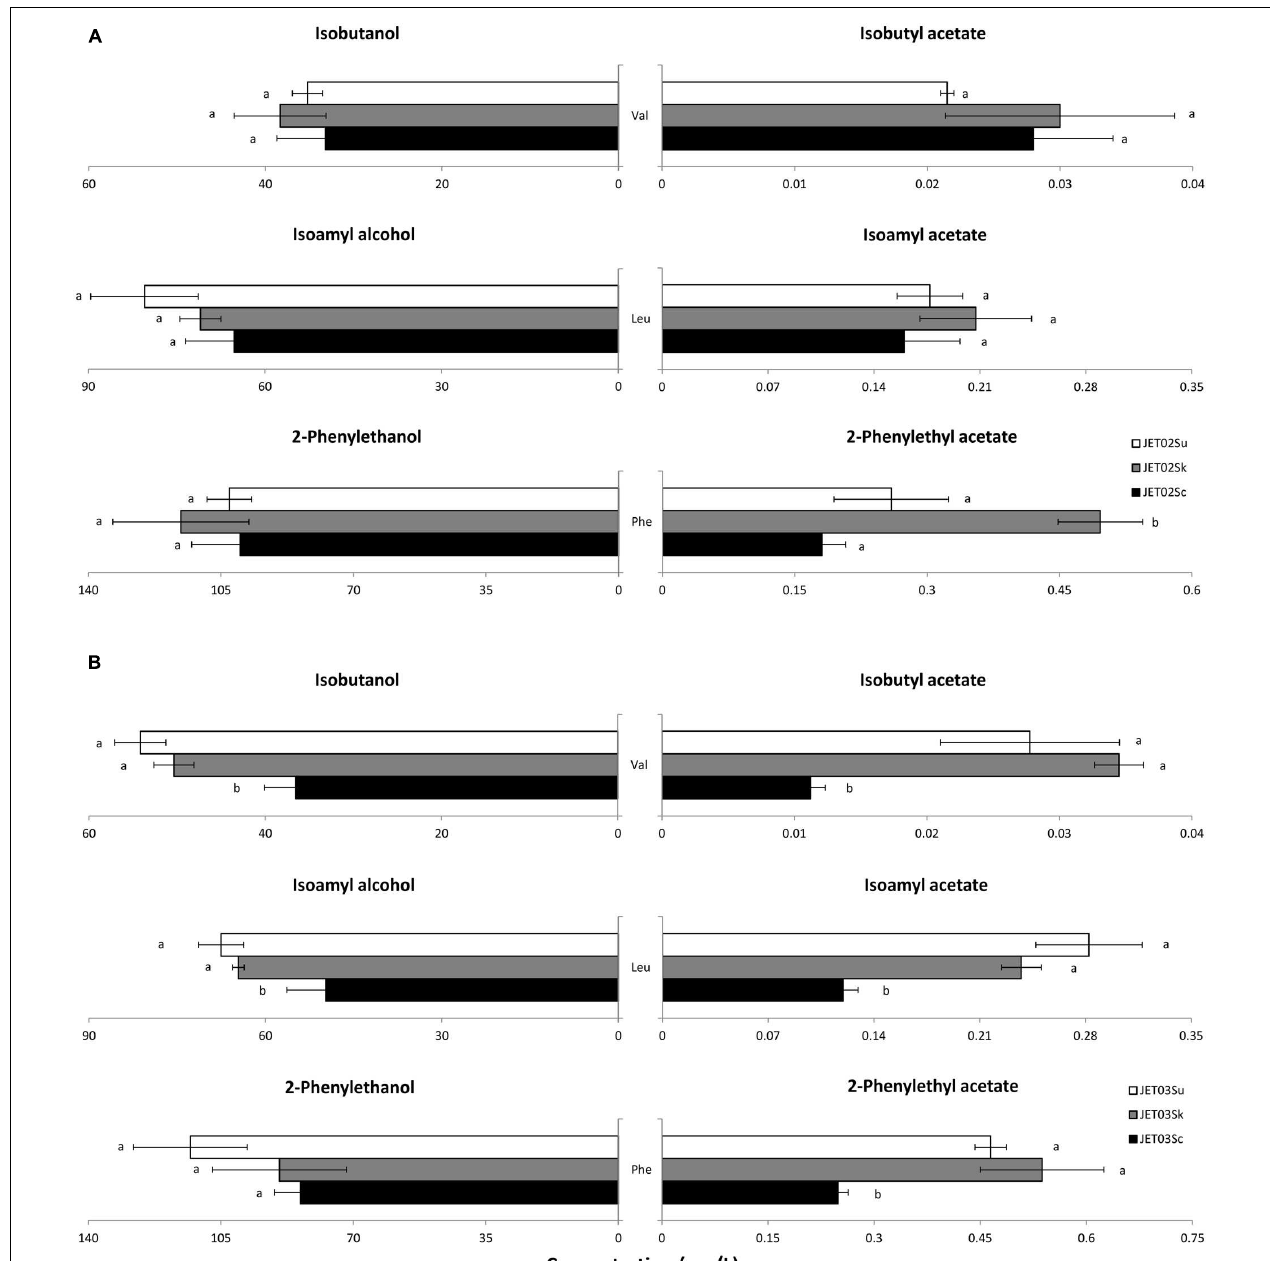
FIGURE 4 | Production of the higher alcohols and esters derived from the corresponding amino acidic precursors used as the nitrogen source (indicated in the graphs). (A) Production of the higher alcohols and esters by the JET02-derived strains that harbored the individual ATF1 orthologs. (B) Production of the higher alcohols and esters by the JET03-derived strains that harbored the individual ATF2 orthologs. The statistically significant differences among the species were determined independently for each nitrogen source and are indicated by labels beside the